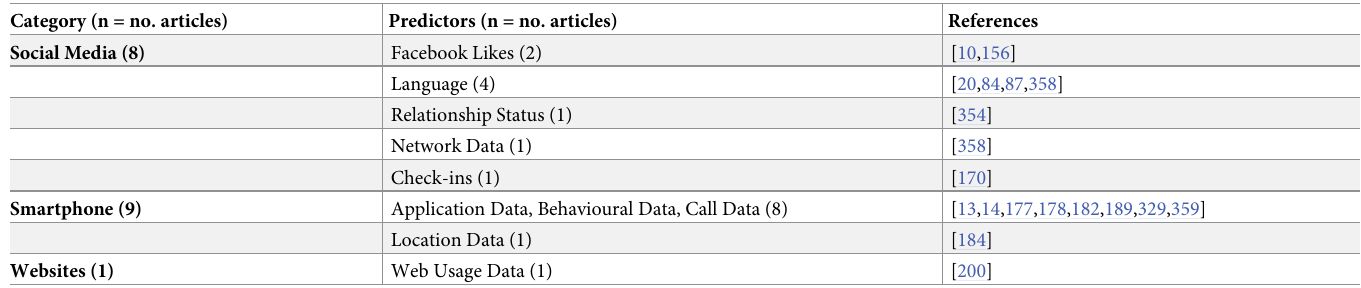
Table 12. Number of articles predicting family and relationship status, with associated predictors and references. Category (n = no.